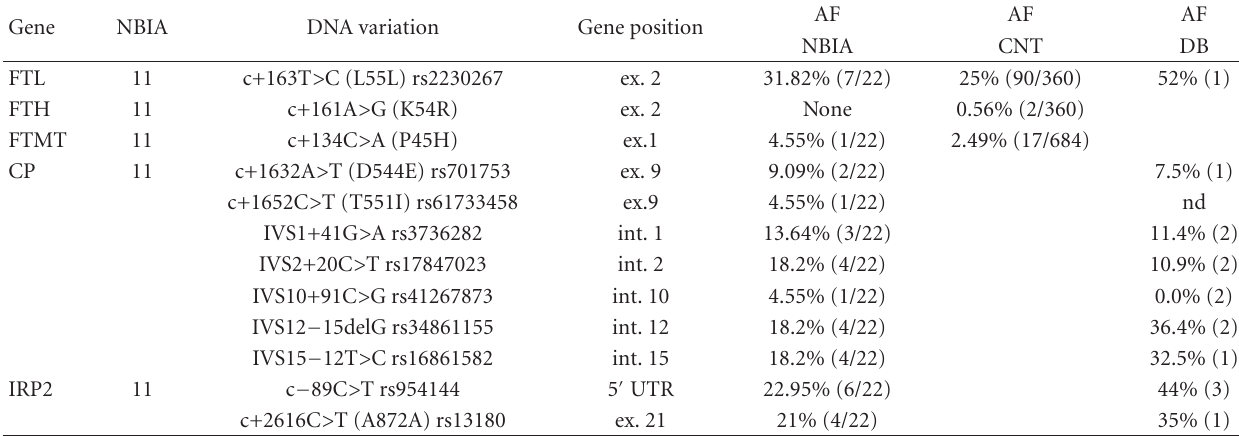
Table 2: Allelic frequencies of the sequence variations identified in CP and IRP-2 genes in sNFT patients. Gene NBIA DNA